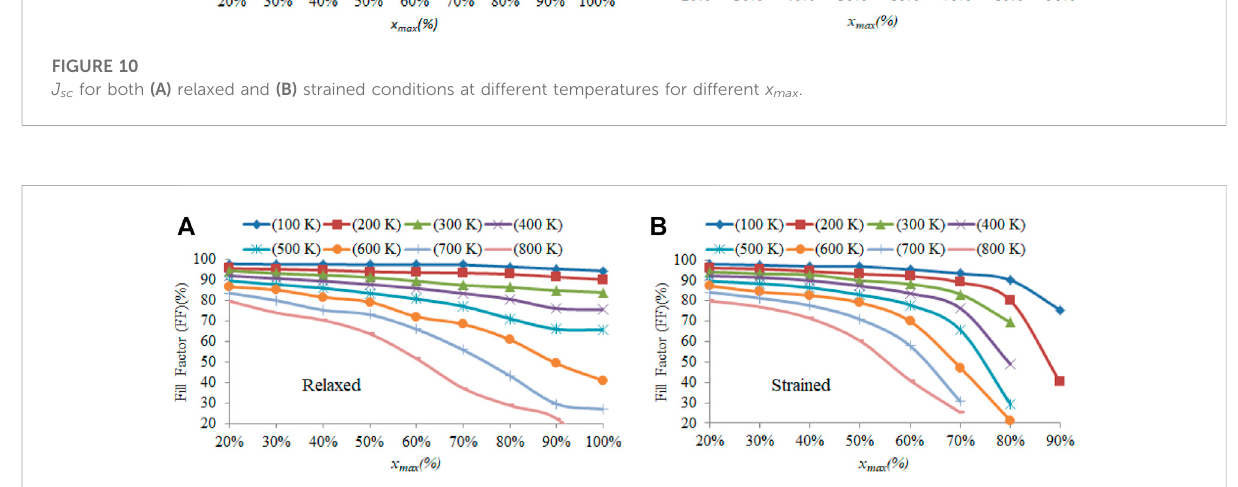
FIGURE 11 Fill factor for the (A) relaxed condition and (B) strained condition for different temperatures. The lines are just guides to the eye.